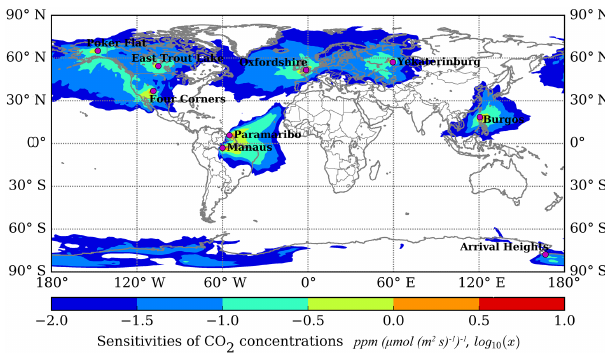
Figure 3. Global distribution of the sensitivity of CO 2 concentra- tions (ppm(µmol(m 2 s) − 1 ) − 1 ) with respect to the concentrations in adjacent cells, calculated using the FLEXPART model with a res- olution of 1.0 ◦ for 9 past, future and possible TCCON operational sites, using a tracer simulation initialised at the level of